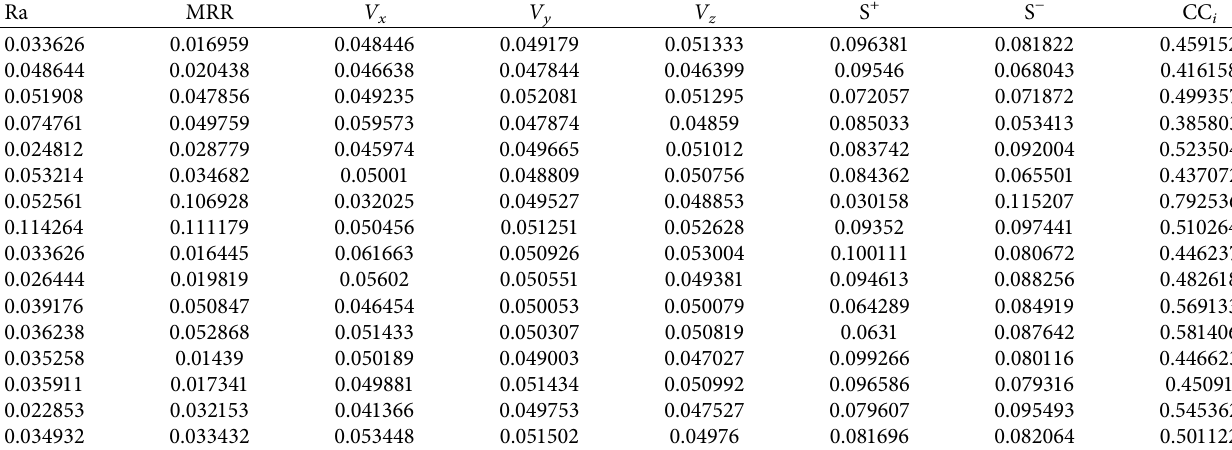
Table 7: Weighted normalization. Measures of separation and closeness coefficient values.